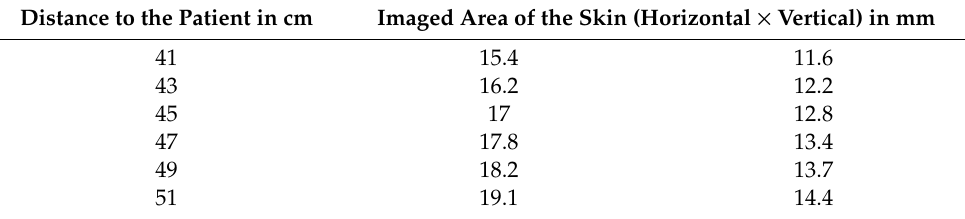
Table 1. Image sizes for different distances to the target.